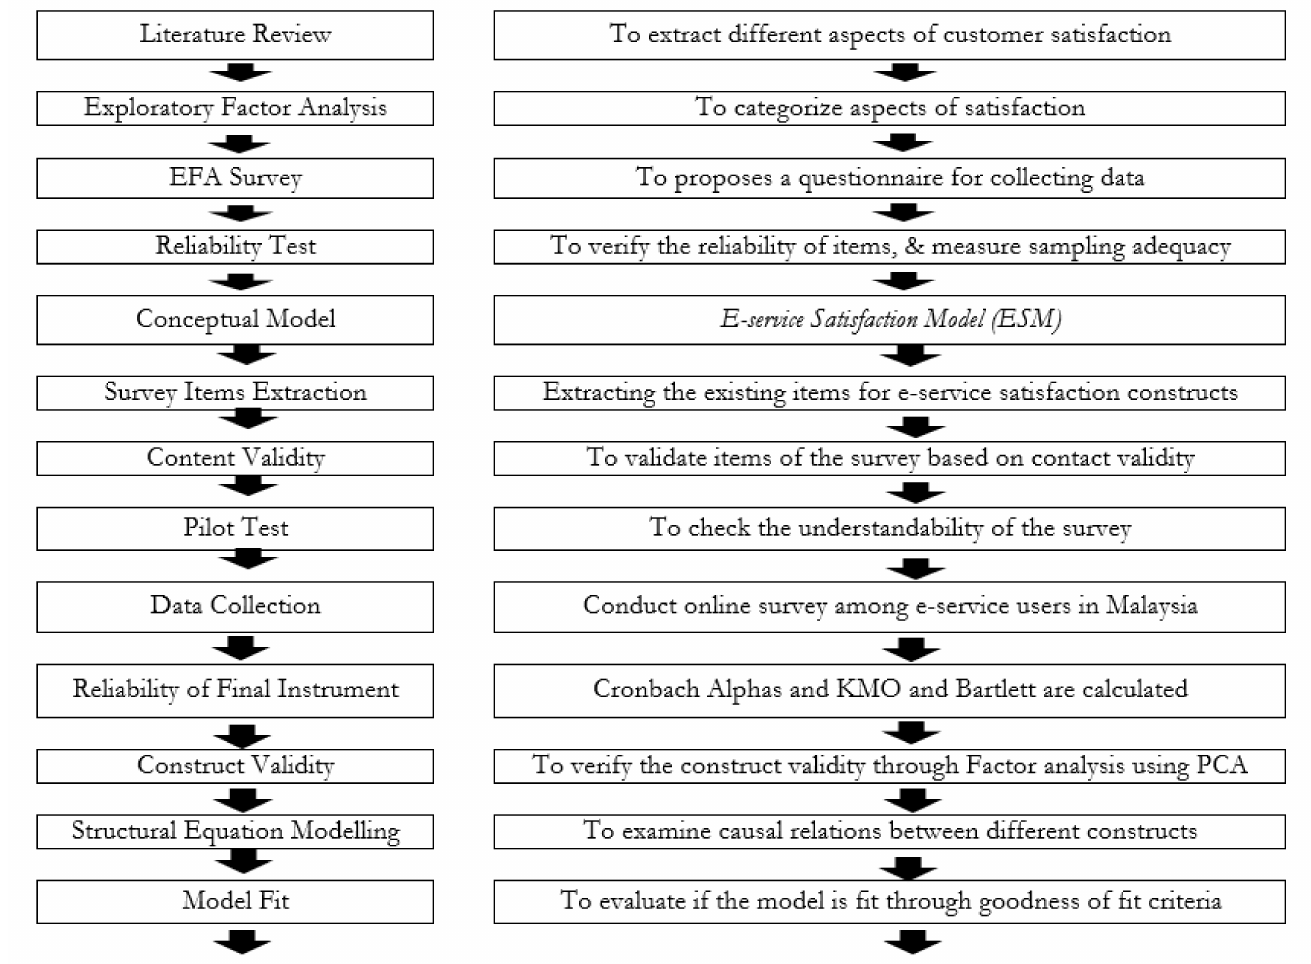
Figure 1. Research process for survey